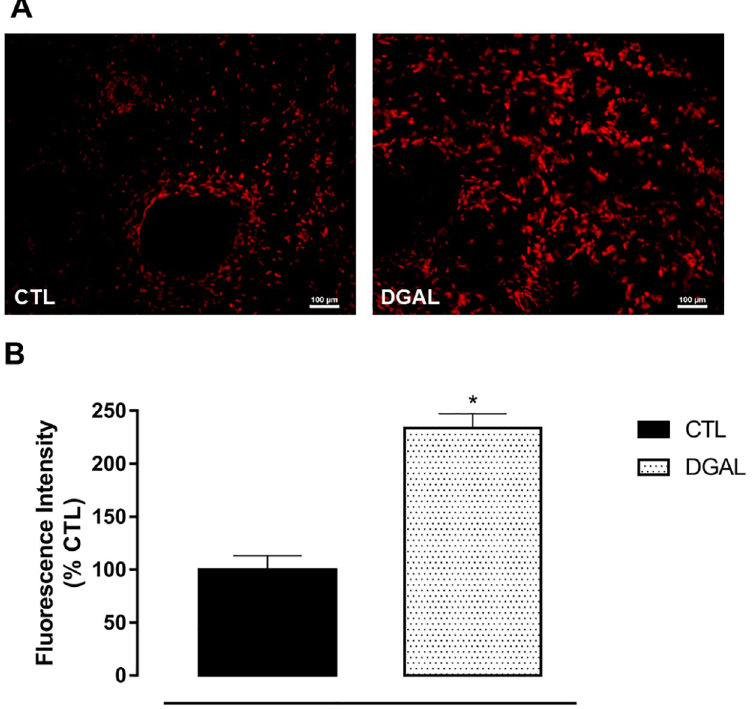
Fig 4. Representative image (A) and quantitative analysis (B) of superoxide anion production as measured by fluorescent intensity emitted by the DHE probe. Corpus cavernosum (8 μ M) isolated from both CTL and DGAL rat groups, treated for eight weeks (20x objective). Groups: CTL (vehicle); DGAL (D-(+)-galactose 150 mg/Kg). Scale bars, 100 μ m. Data are expressed as mean values of the percentage of fluorescence relative to the control ± SEM (n = 4). The data were analyzed using the Student’s t-test. � p < 0.05 vs